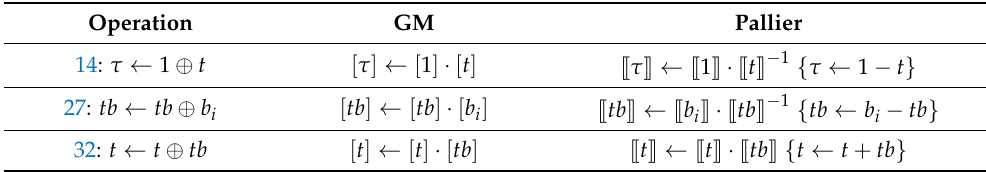
Table 1. Operations and their encrypted